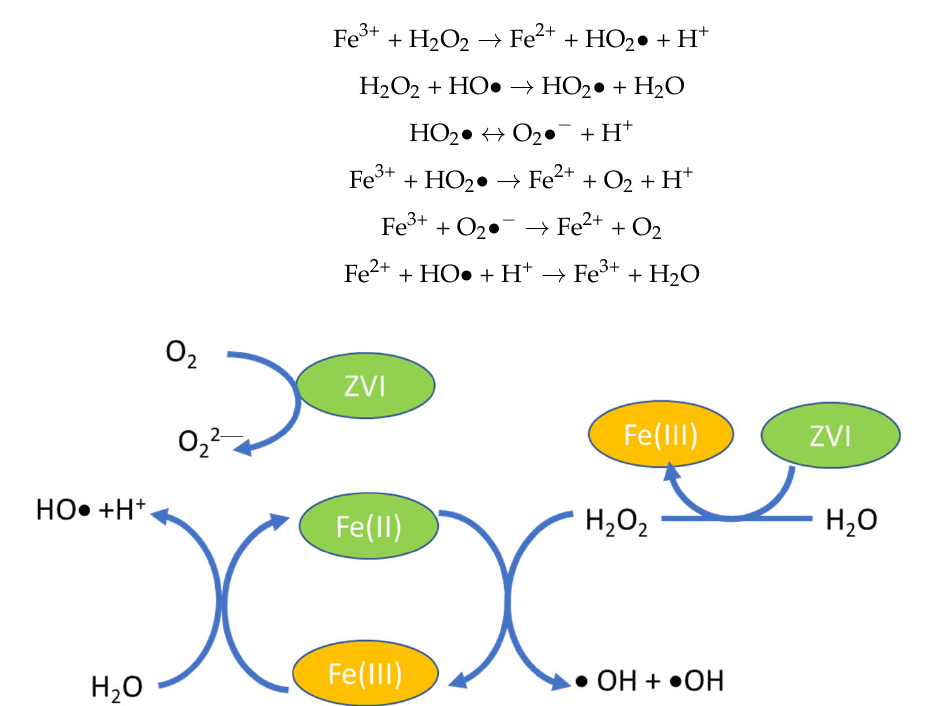
Figure 2. Diagram of the reduction–oxidation by Fe 2+ /Fe 3+ .